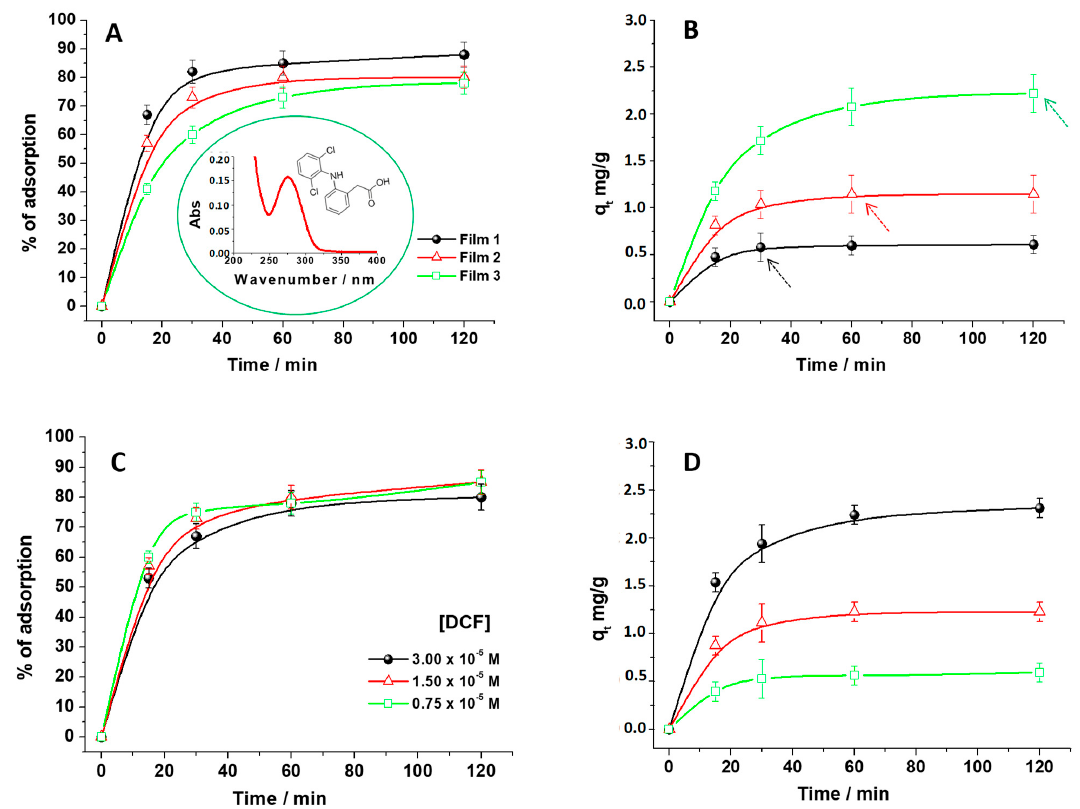
Figure 1. ( A , B ) The percentage of DCF adsorption onto chitosan film, with the related adsorption capacities, q t , by adopting a DCF solution 1.50 × 10 − 5 M, at pH 5, and three di ff erent chitosan film weights, Film 1 > 2 > 3, ( C , D ) by changing the DCF concentrations, 0.75 × 10 − 5 M, 1.50 × 10 − 5 M, 3.00 × 10 − 5 M, at pH 5, using Film 2.